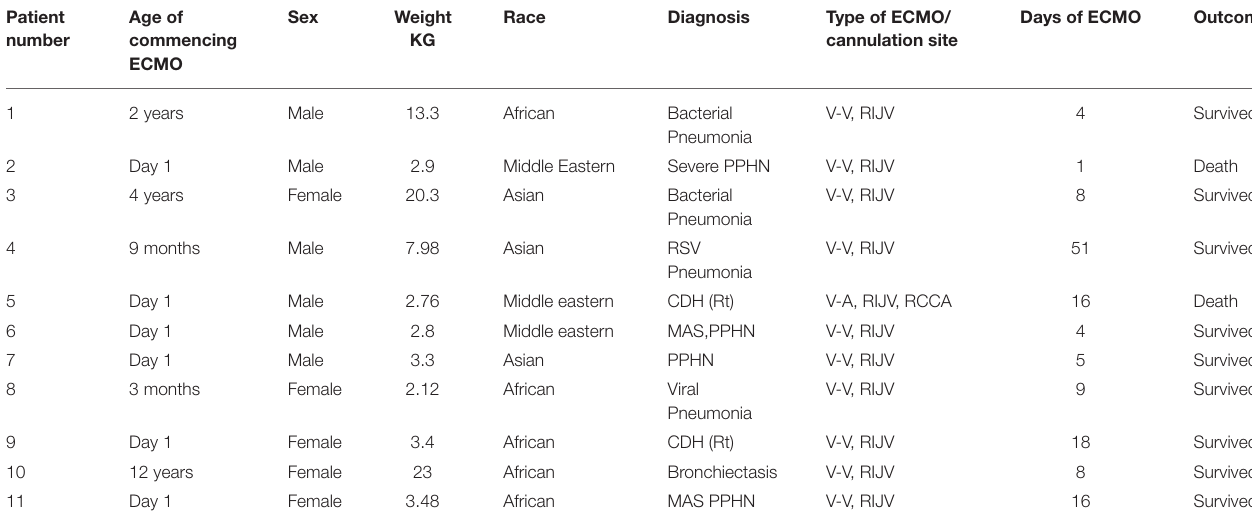
V-V, Veno-venous; RIJV, Right Internal Jugular vein; RCCA, Right common carotid artery.